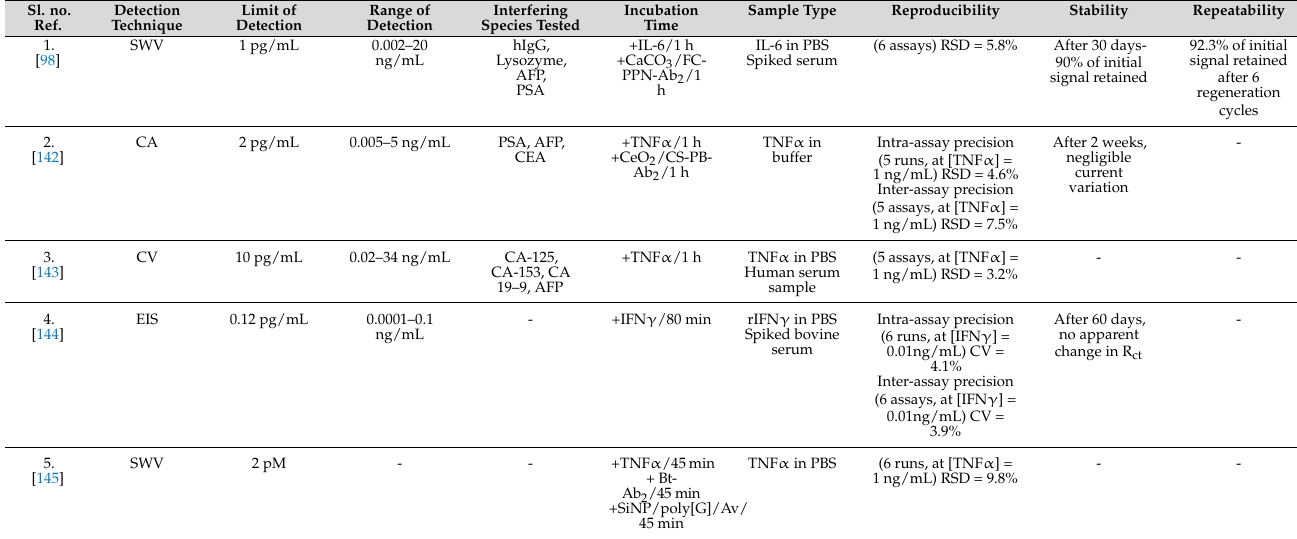
Table 10. Redox-labeled immunosensors: Specifications and performance characteristics. Sl. no.